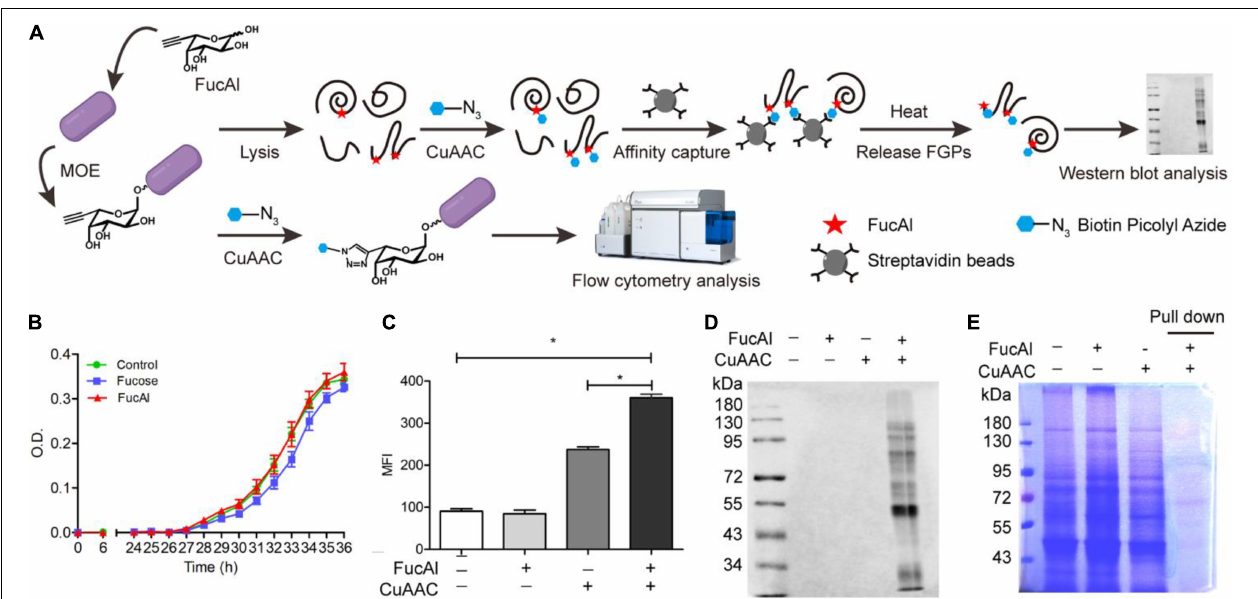
FIGURE 1 | Detectionof B. thetaiotaomicron’ s FGPs by metabolic labeling and CuAAC. (A) Workflow for labeling, enrichment and analysis of FGPs in B. thetaiotaomicron . (B) Evaluation of biocompatibility of FucAl in B. thetaiotaomicron by bacterial growth curve. (C) Flow cytometry analysis of labeling efficiency of